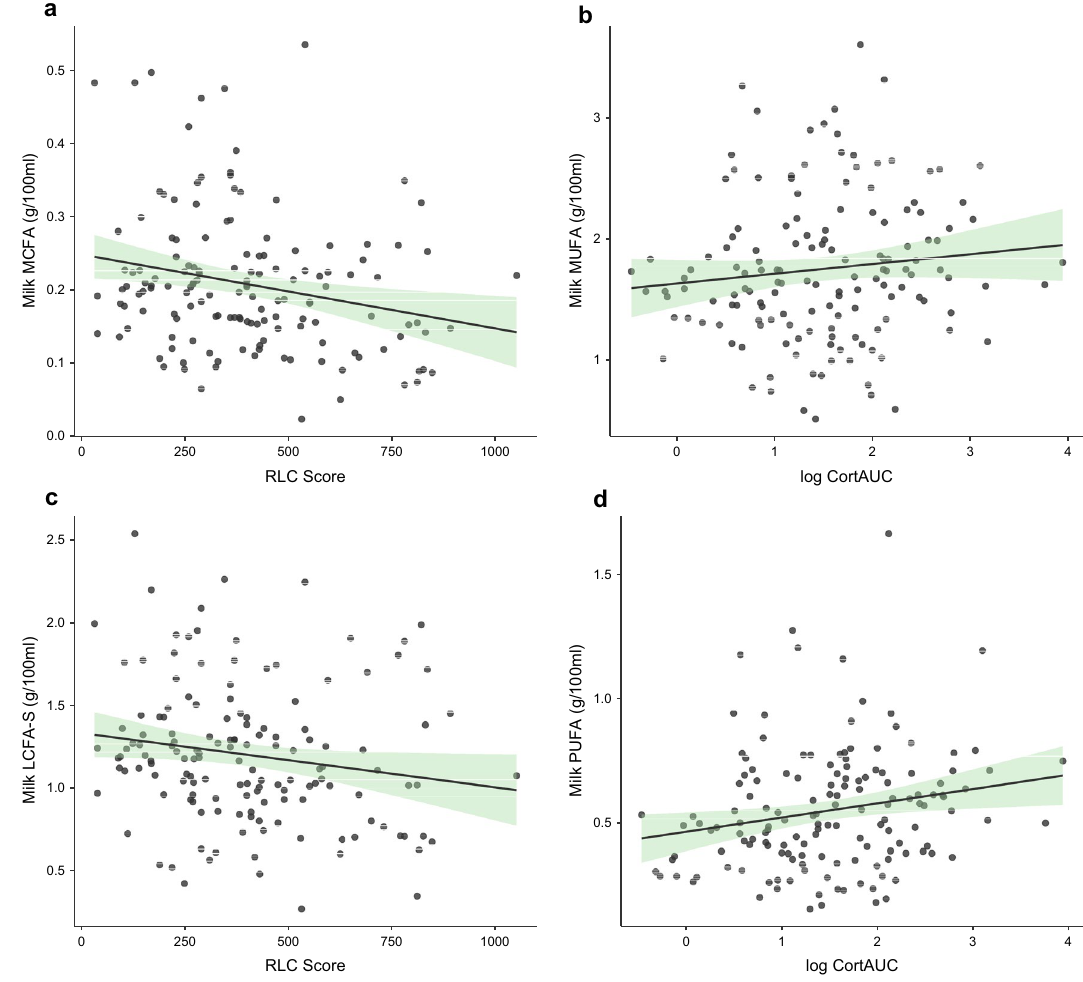
Figure 2. Maternal stress (RLC) and cortisol levels are associated with the level of fatty acids in milk. Higher maternal stress (RLC) is associated with lower levels of MCFA (panel a ) and LCFA-S (panel c ). Higher level of maternal cortisol is associated with higher levels of MUFA (panel b ) and PUFA (panel d